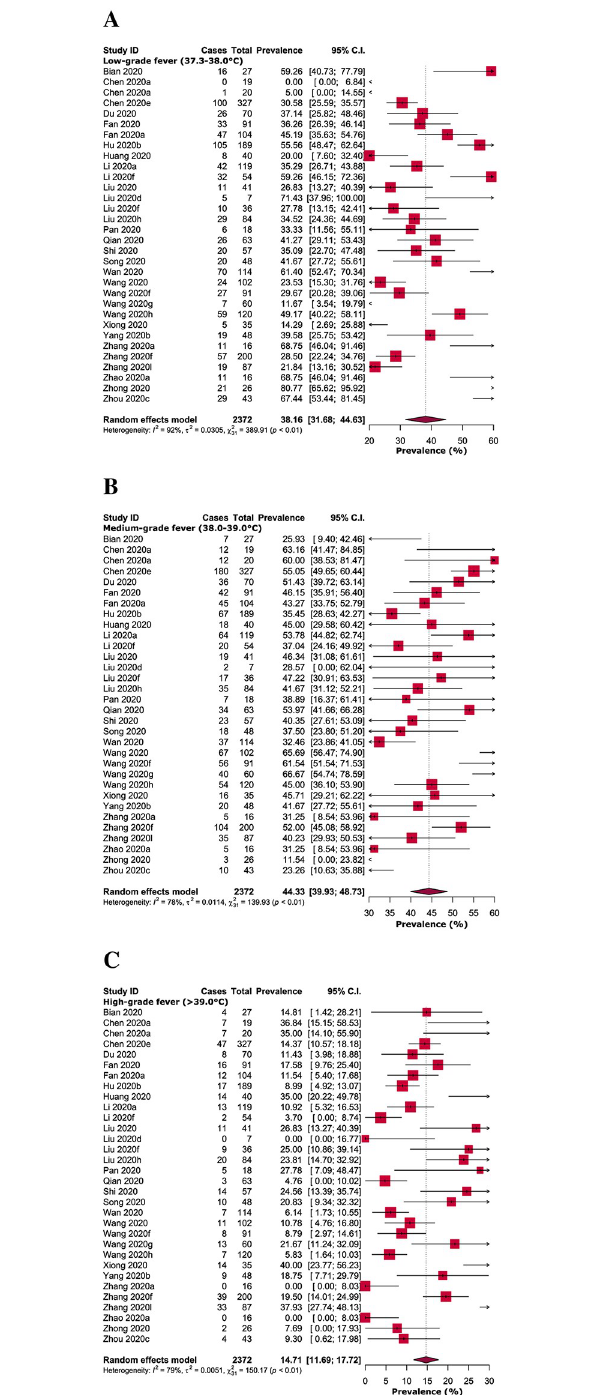
Fig 4. Prevalence of (A) low (37.3–38.0˚C), (B) medium (38.0–39.0˚C) and (C) high-grade ( > 39.0˚C) fever in adult COVID-19 patients.